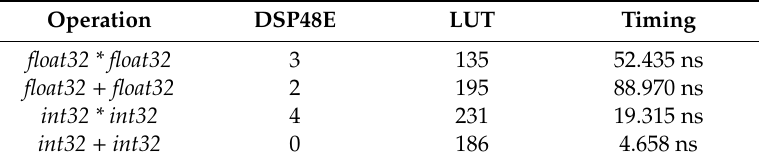
Table 2. Parameters used in the Boost converter.